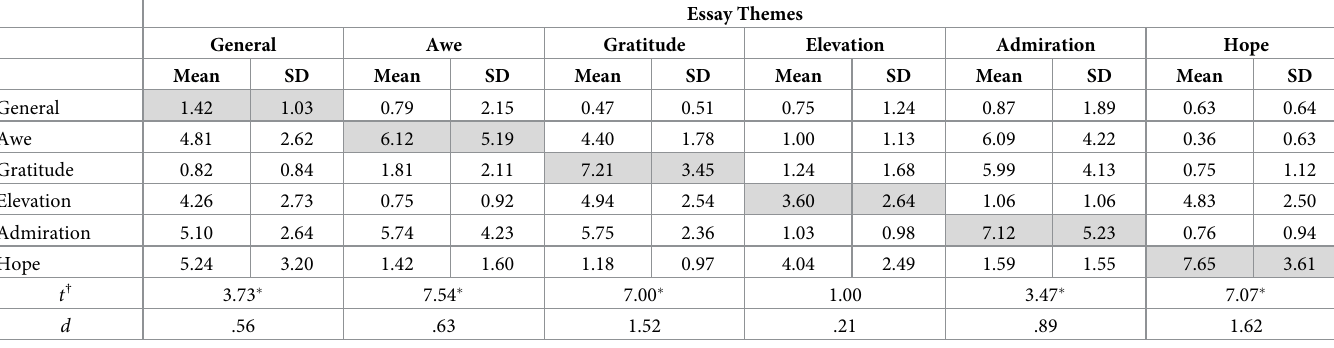
Table 2. Percentage of terms for each self-transcendent construct as identified in construct-themed essays.